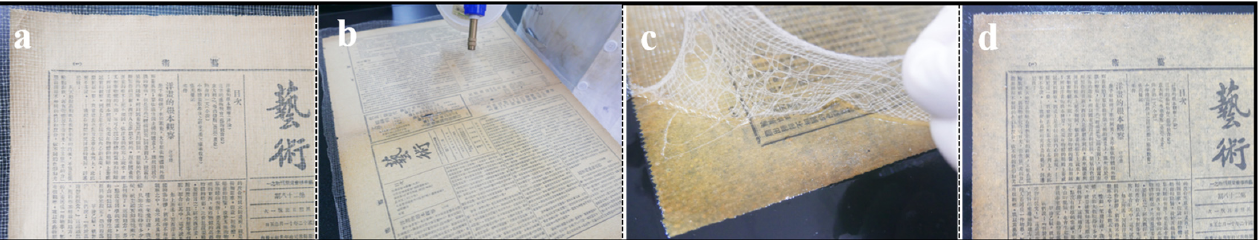
Figure 4. Reversibility process: before ( a ) and after ( d ) removing reinforcement material; spraying of ultra-pure water ( b ); of removal of cotton mesh ( c